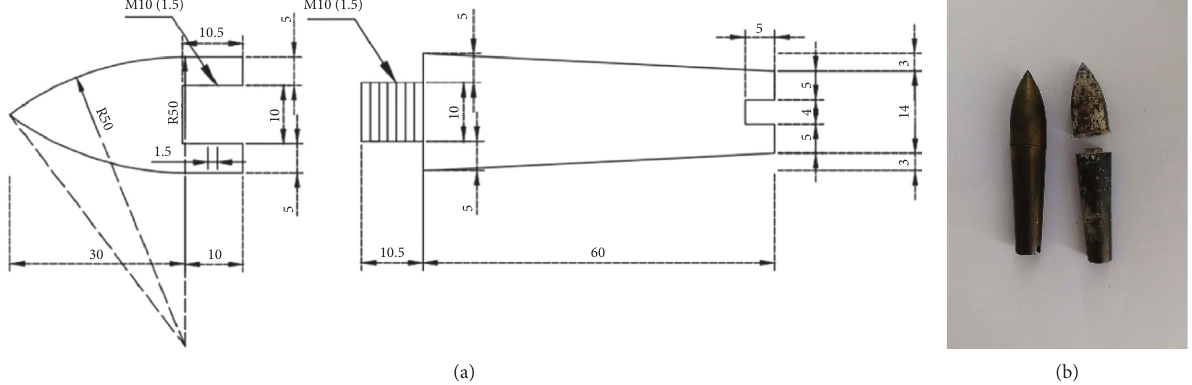
Figure 1: Penetration projectile (a) design drawing and (b) before and after penetration.